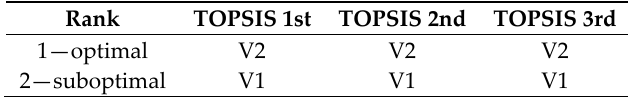
Table 2. Final ranking of alternatives using the Technique for Order Preference by Similarity to Ideal Solution (TOPSIS) method: TOPSIS 1st, using an impartial approach; TOPSIS 2nd, using an environmental approach; and TOPSIS 3rd, using an economical